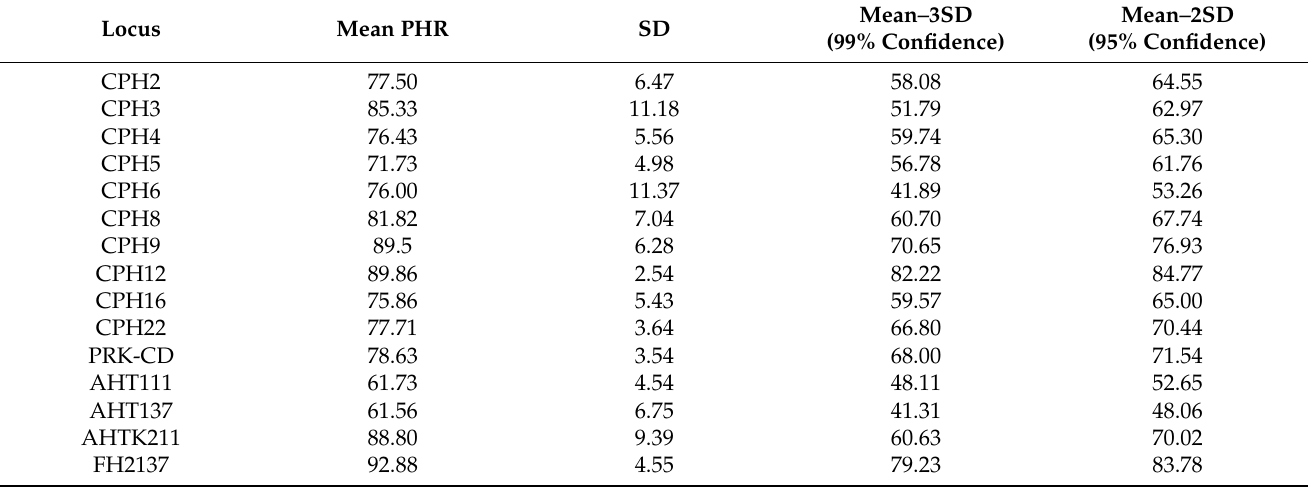
Table 2. Peak height ratios (PHR) multiplied by 100, based on 20 heterozygotes analyzed for each locus. Lower PHR ranges are assessed as the mean decrease by three (and two) times the standard deviation (SD). NE = negative value. Values in parentheses were obtained by excluding from calculations the alleles that caused strong peak imbalance (see text for